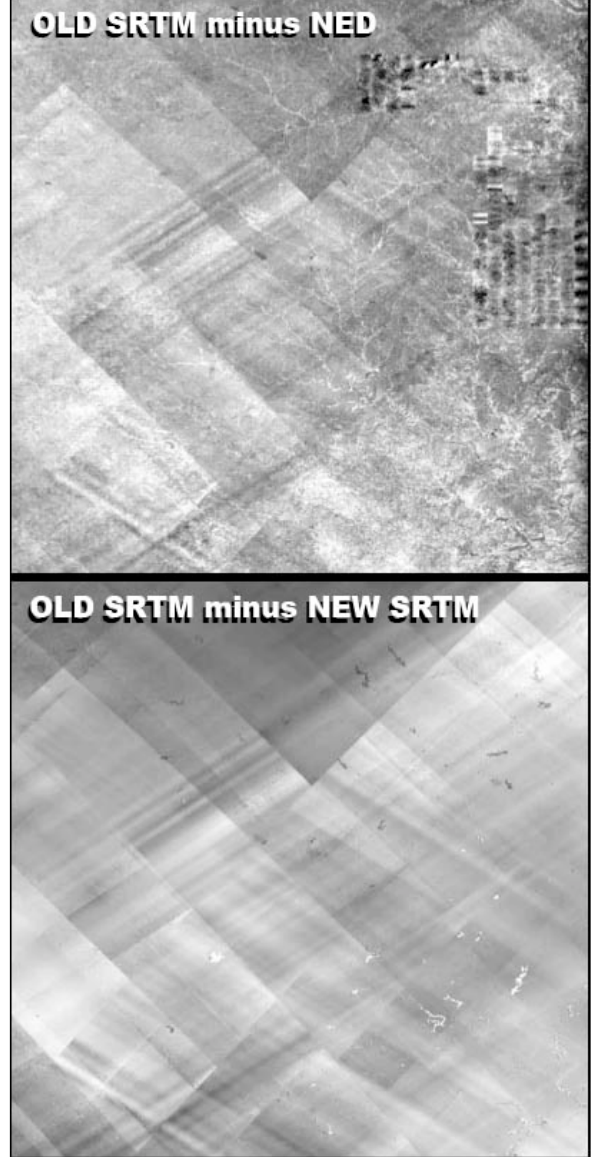
Figure 2. Old SRTM swath height errors evident versus both NED and the new SRTM, in which they have been